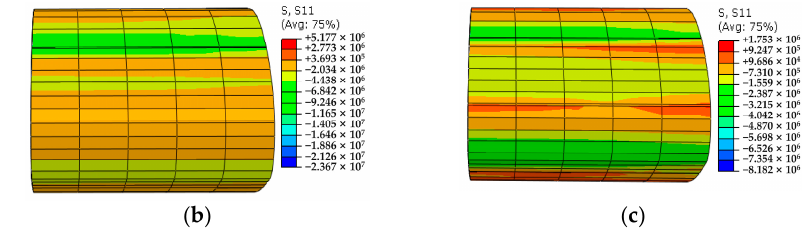
Figure 13. The horizontal stress of the primary support in different conditions (unit: Pa): ( a ) Condition 1; ( b ) Condition 2; and ( c ) Condition 3.